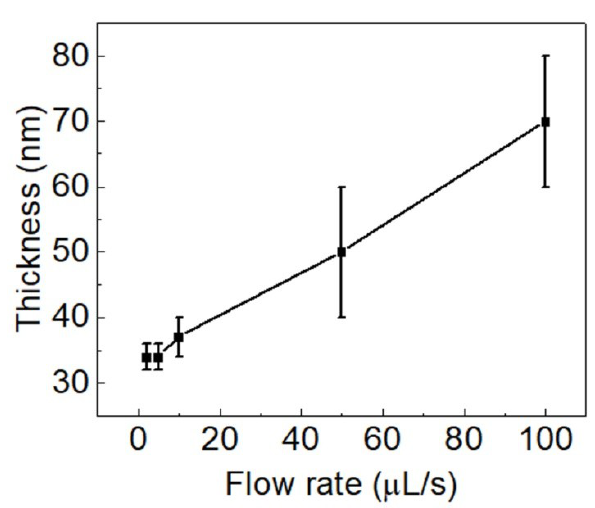
Figure 7. Thickness of PEDOT:PSS films which were deposited through slot-die coating process at different flow rates. The substrate temperature and coating speed were kept constant at 30 °C and 1 mm/s, respectively. The vertical bars indicate the range of variation of the film thickness in the same sample.